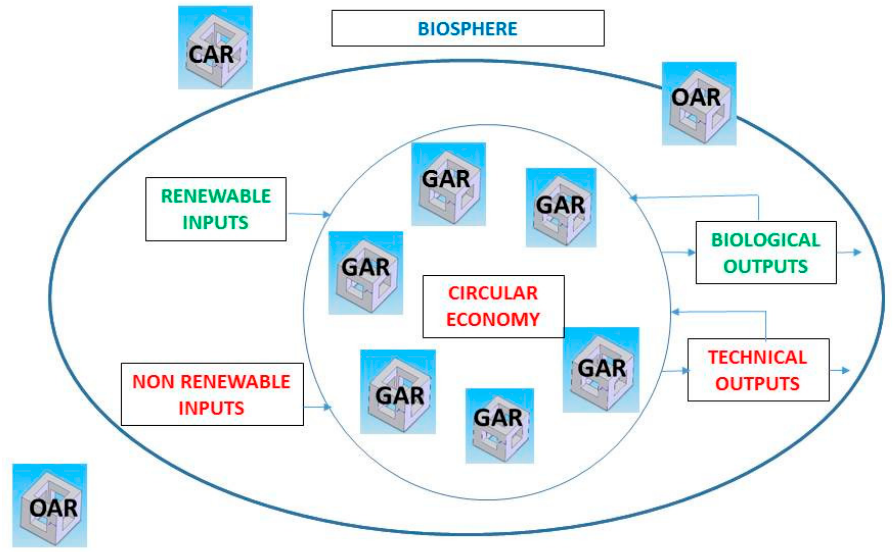
Figure 1. The adequate size of an economic system and types of viable artificial reefs. GAR: green artificial reef; CAR: conventional artificial reef; OAR: opportunity artificial reef.